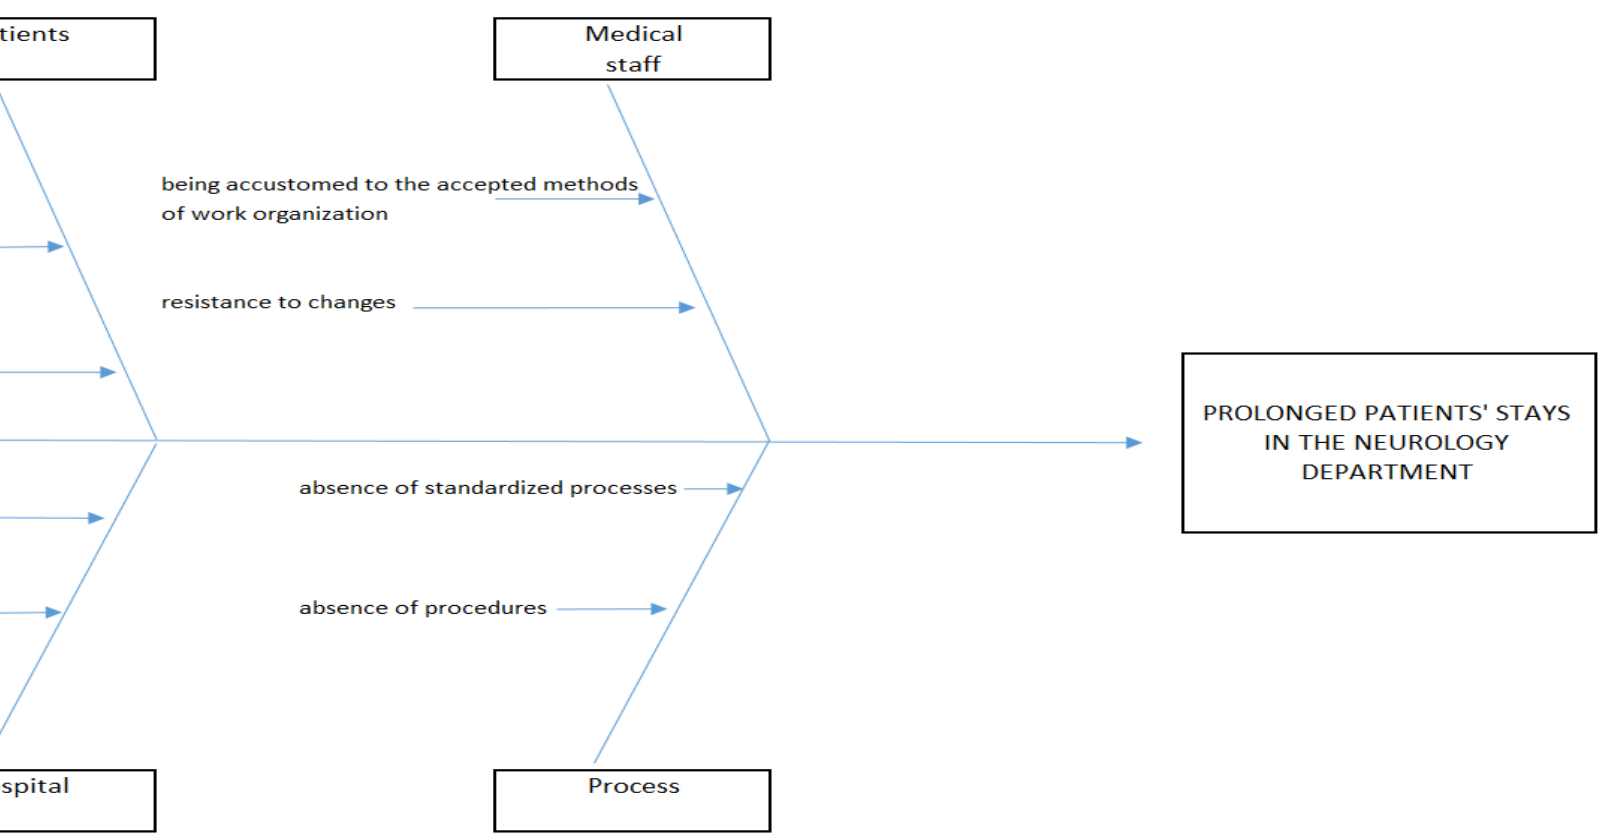
Figure 1. The Ishikawa diagram — analysis of causes of prolonged stays at Department III.